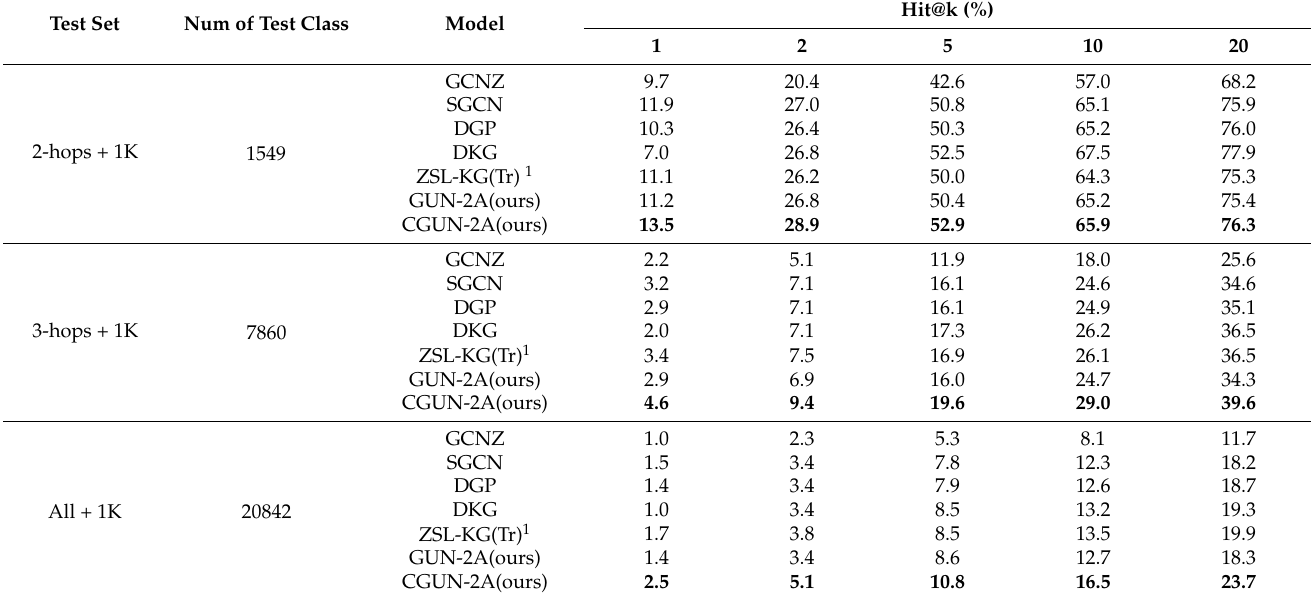
Table 2. Hit@k performance for different methods on three datasets. Testing on both the seen and unseen classes.